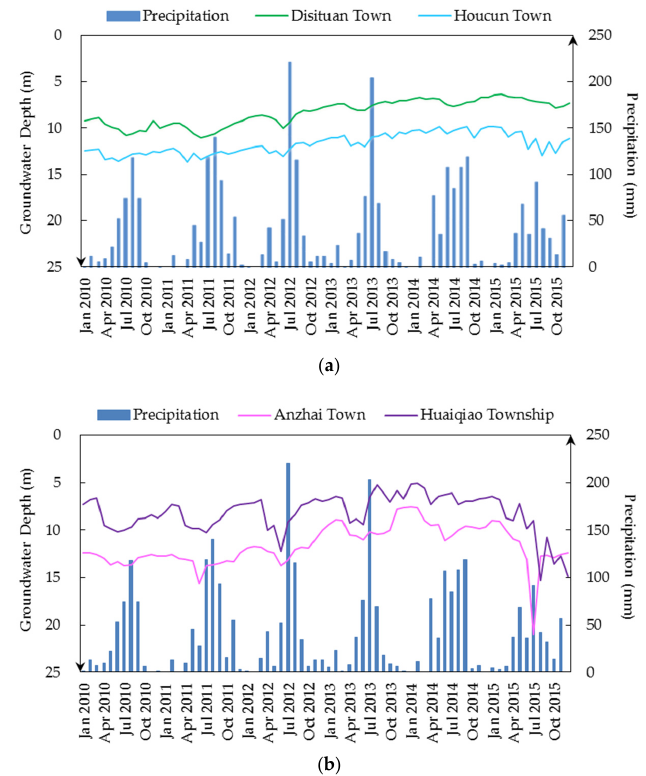
Figure 8. The variation of groundwater depth in project regions ( a ) and non-project regions ( b ) in Quzhou County.